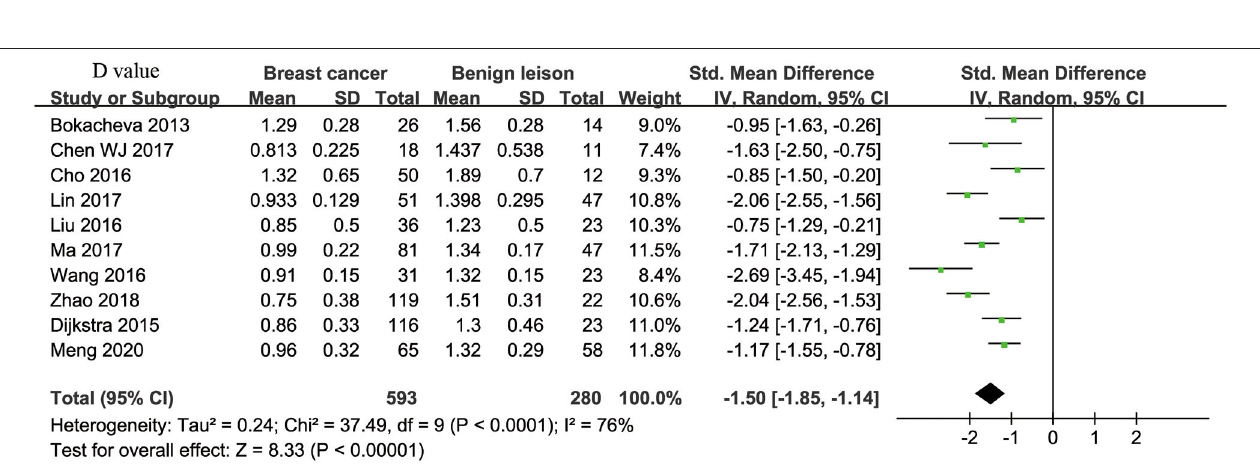
FIGURE 4 | Forest plot of the mean value of tissue diffusivity (D) between malignant and benign breast lesions. The standardized mean differences (SMDs) indicated that breast cancers had a significantly lower D value than did benign lesions.